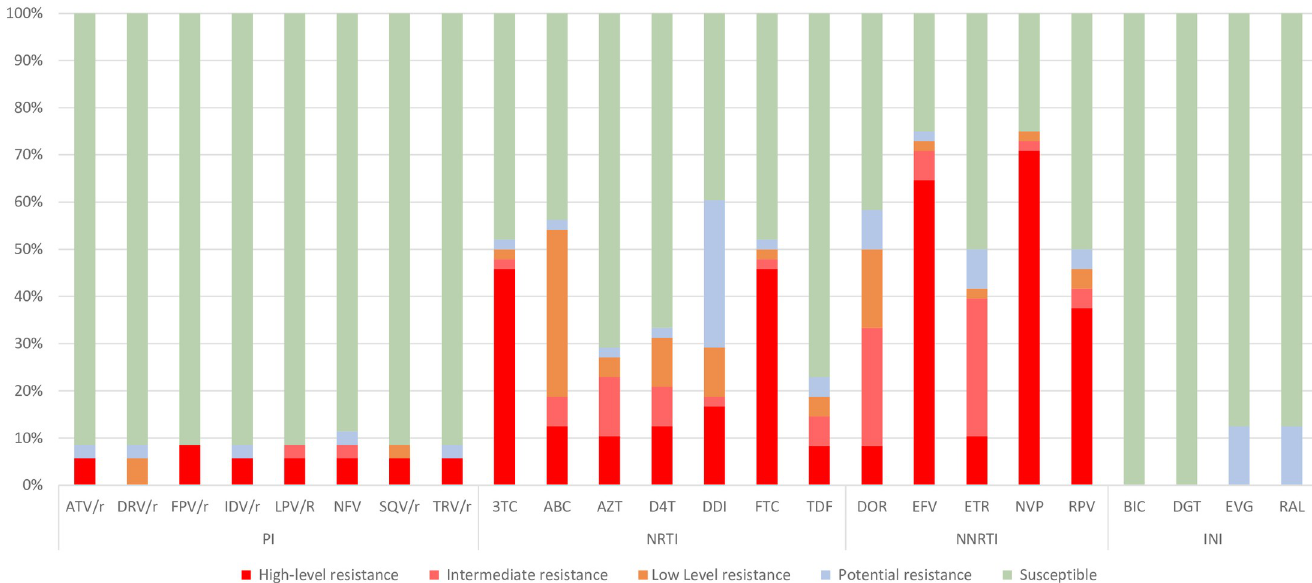
Fig 4. Predicted ARV susceptibility by Stanford in patients with available sequence. Predicted ARV susceptibility in 38PR/49RT/40IN available sequences from 55 children/adolescents under study. NRTI, nucleoside reverse transcriptase inhibitor; NNRTI, non-nucleoside reverse transcriptase inhibitor; PI, protease inhibitor; INI, integrase inhibitor; ATV/r, Atazanavir/Ritonavir; DRV, Darunavir; FPV, Fosamprenavir; IDV/r, Indinavir/Ritonavir; LVP/r, Lopinavir/Ritonavir; NFV, Nelfinavir; SQW, Saquinavir; TPV/r Tipranavir/Ritonavir; ABC, Abacavir; AZT, Zidobudine; D4T, Estavudine; DDI, Didanosine; FCT, Emtricitabine; 3TC, Lamivudine; TDF, Tenofovir; DOR: Doravirine; EFV, Enfavirez; ERT, Etravirine; NVP, Nevirapine; RPV, Rilpivirine; DGT, Dolutegravir; EVG, Elvitegravir; RAL, Raltegravir. Information per patient in S1 Fig .